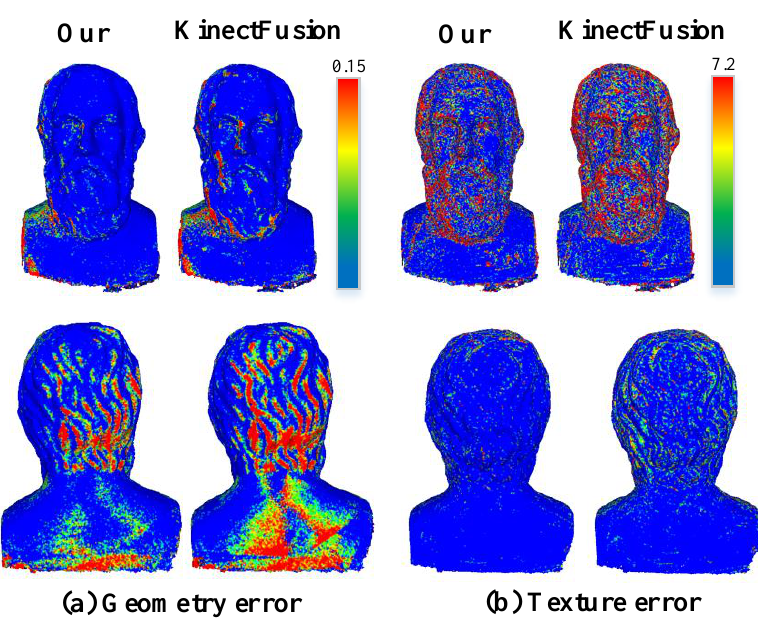
Figure 9. Quantitative analysis of geometry ( a ) and texture ( b ) based on our method and traditional weighted average fusion method [6]. Table 2. Quantitative analysis results of geometric reconstruction accuracy at different noise levels. Experimental Condition